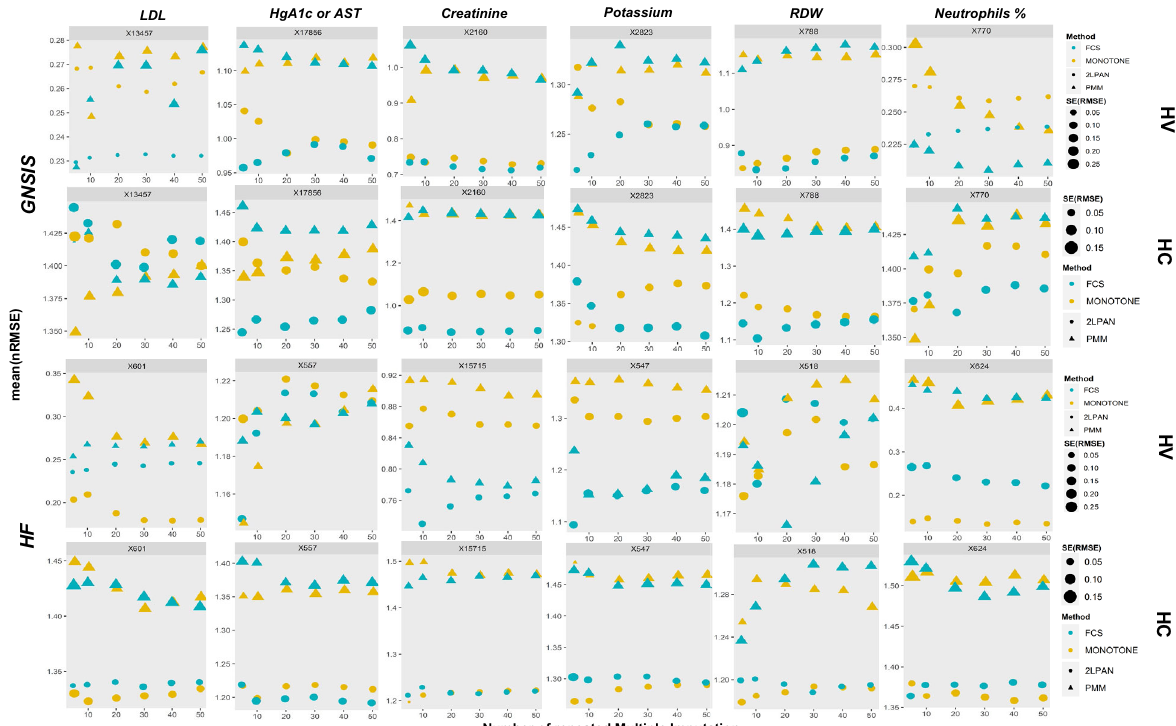
Fig. 5 Laboratory test, missingness pattern, and imputation algorithm dependent uncertainty propagation during 50 repeated multiple imputation (MI) for holdouts using RMSE. The y -axis was labeled with mean(nRMSE) after the number of MI. This mean of normalized RMSE in y -axis represents the error over the number of runs. The size of the triangle or round dot represents the standard error of RMSE over the number of runs. “ L ” shaped or inverse “ L ” shaped distribution of the mean(nRMSE) after 50 runs of MI suggested this uncertainty reached a plateau. However, for some variables (e.g., 13457-7 of LDL or 17856-6 of HgA1C) in HC, the uncertainty went upward but not reached a statistical